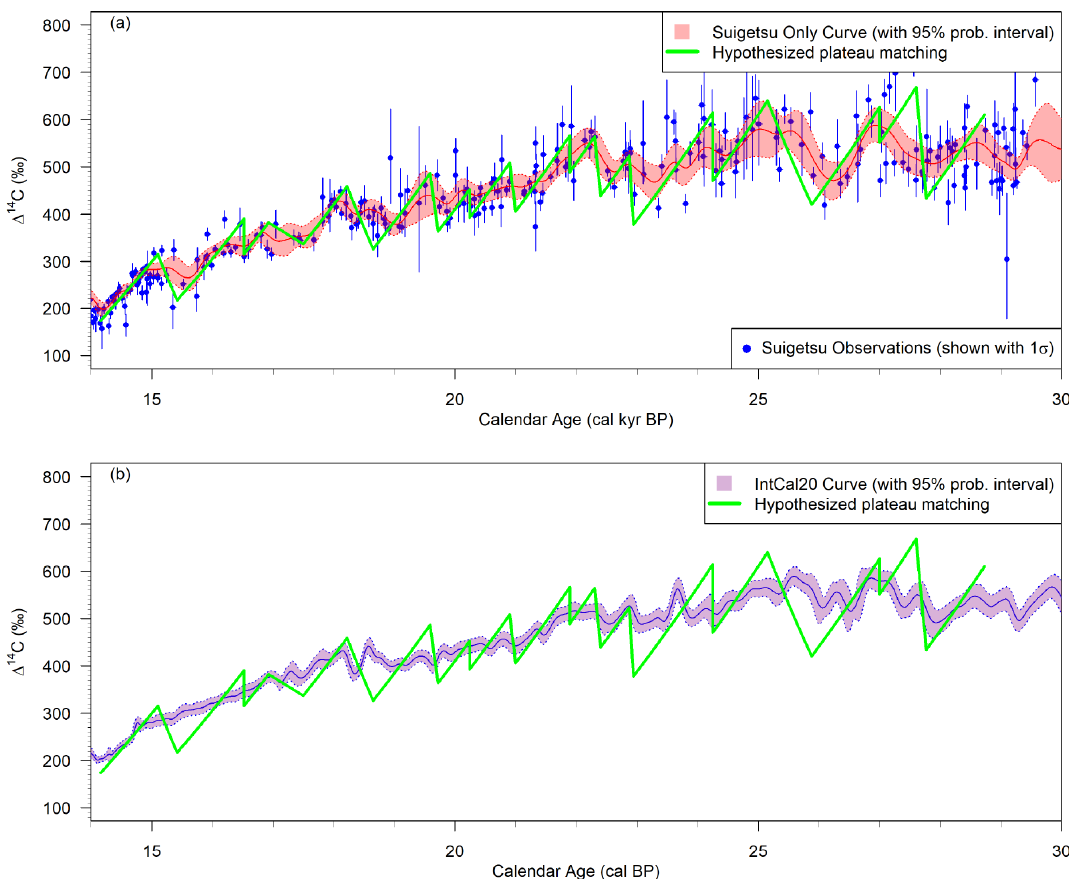
Figure 3. The two panels represent the same data shown in Figs. 1 and 2 but converted into (cid:49) 14 C with units in ‰. Short (or zero) gaps between plateaus are transformed into abrupt rises. Age plateaus correspond to the second parts of these atmospheric (cid:49) 14 C wiggles, during which the (cid:49) 14 C decrease compensates the radioactive